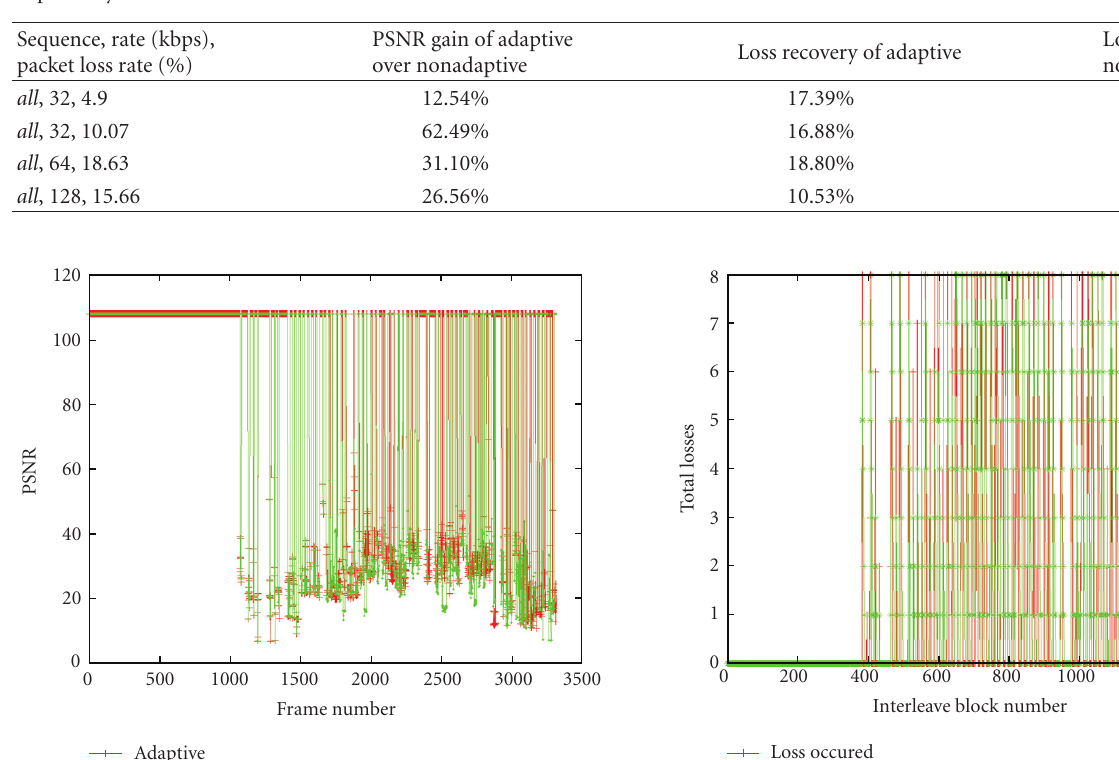
Table 2: Comparison of the performance for all at data rates 32, 64, and 128 kbps at packet losses of 4.9%, 10.07%, 18.63%, and 15.66%, respectively.